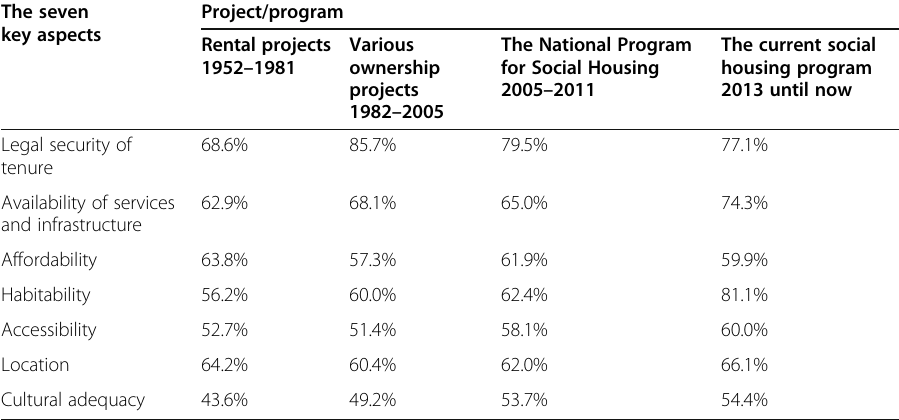
Table 2 The percentage of average realization of the seven key aspects in the affordable